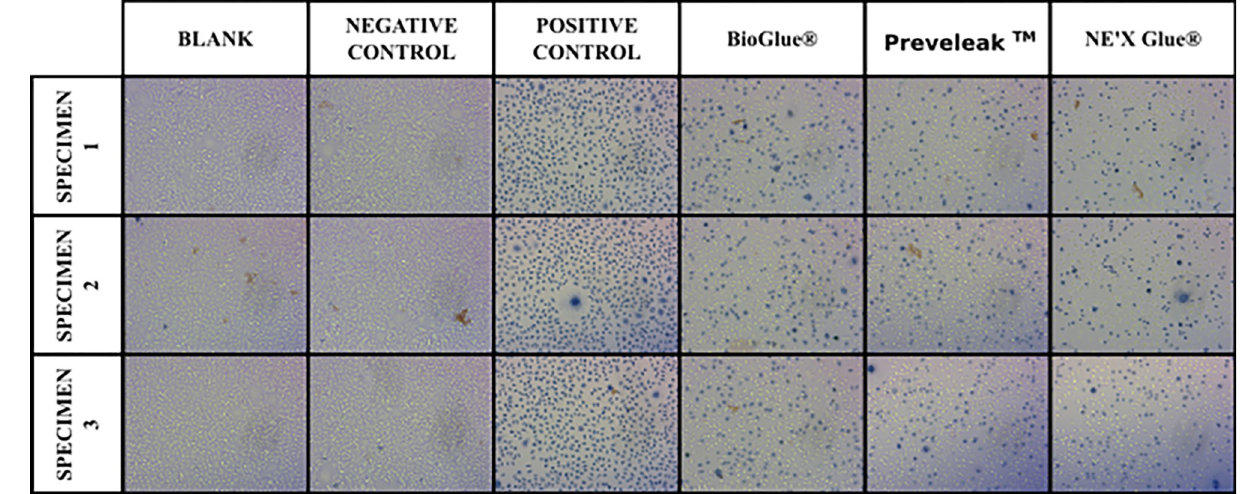
Fig 1. Images of cells after exposure to surgical adhesive extracts in the MEM elution